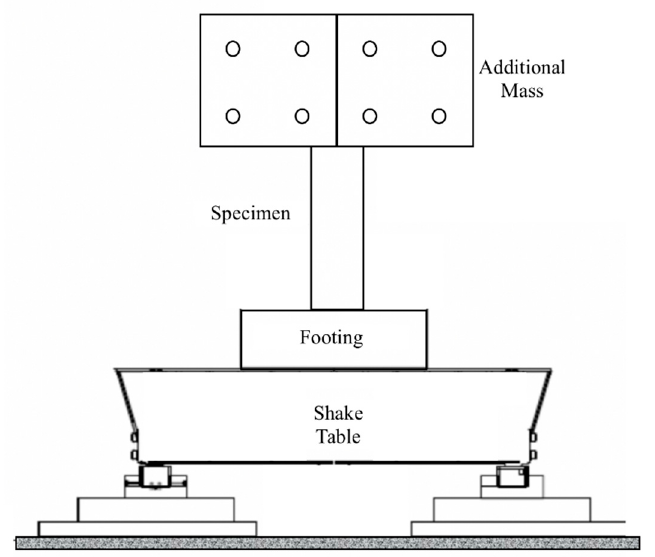
Figure 2. Representation of an inertial mass without auxiliary-supporting structure.